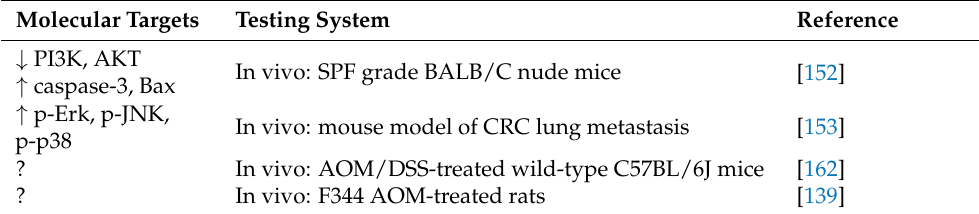
Table 6. Reported targets of quercetin active in the reduction in tumor size of CRC models along- side their in vivo testing system. “ ↑ ” and “ ↓ ” arrows are indicating the up- and down-regulation, respectively, while “?” denotes the lack of specific targets in the respective studies.